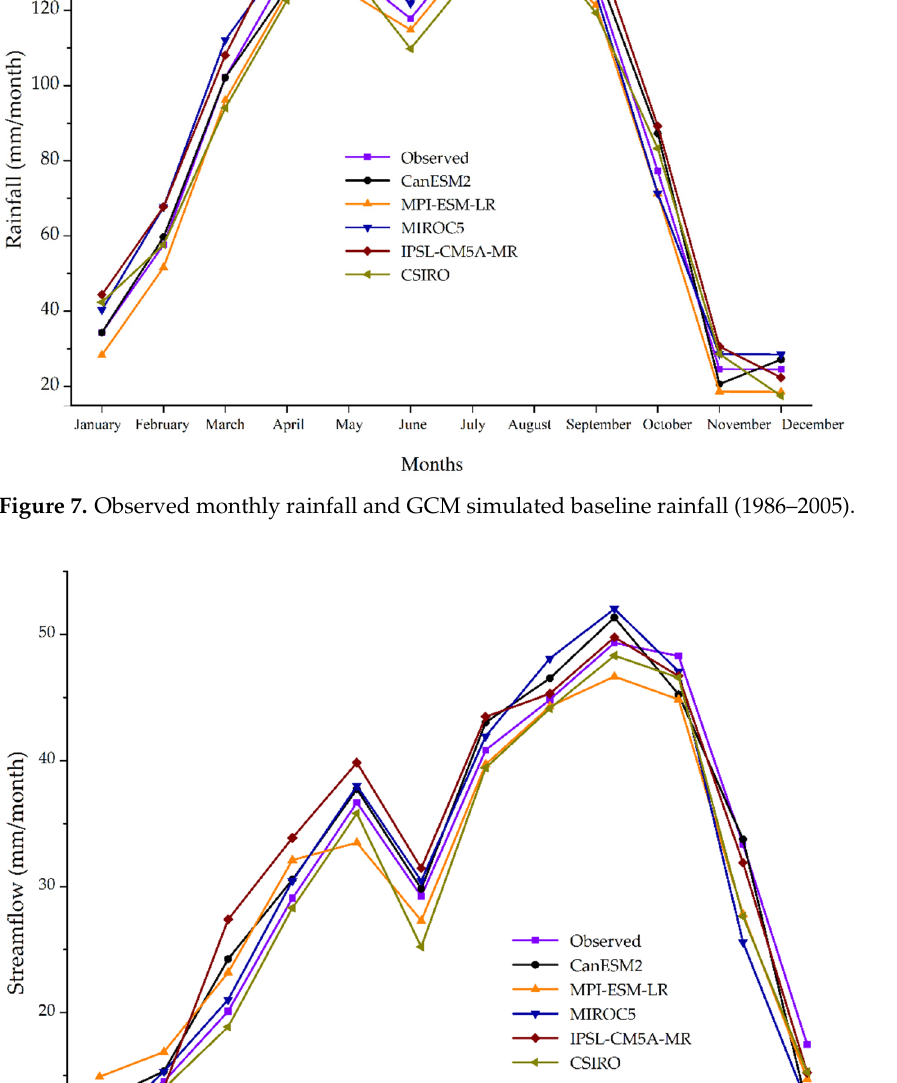
Figure 7. Observed monthly rainfall and GCM simulated baseline rainfall (1986–2005).